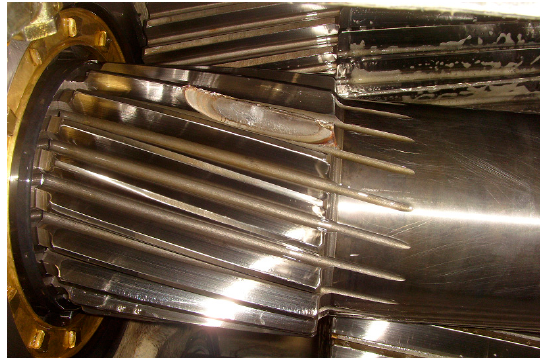
Figure 13. Broken pinion on high-speed shaft of a wind turbine gearbox.